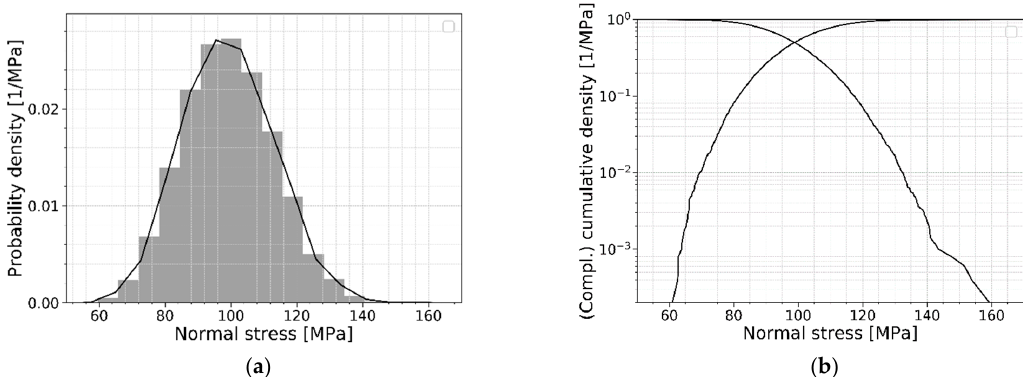
Figure 10. ( a ) Probability density and ( b ) (compl.) cumulative density of the normal stress.